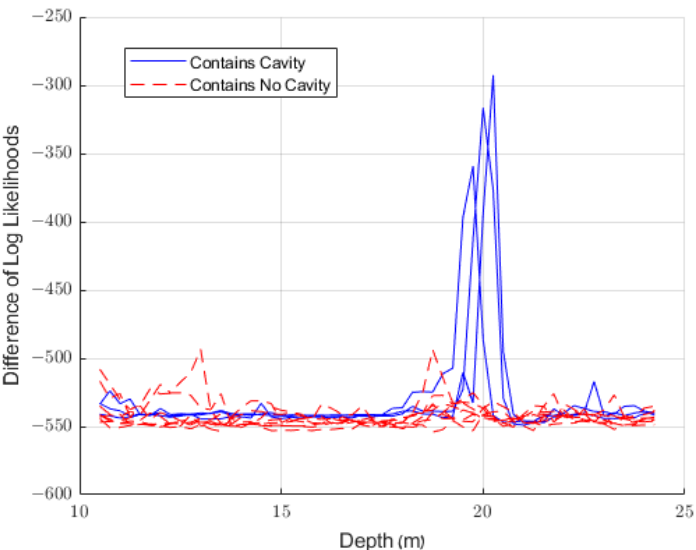
Figure 12. The results of applying our method to real measurements. The cavity, when it exists, is located around 19 or 20 m below the surface. We examined the frequency range of 36–52 MHz, used a window size of one depth (0.25 m), and used a guard distance of 6 depths (1.5 m). The cavity was assumed to have a width of 1.5